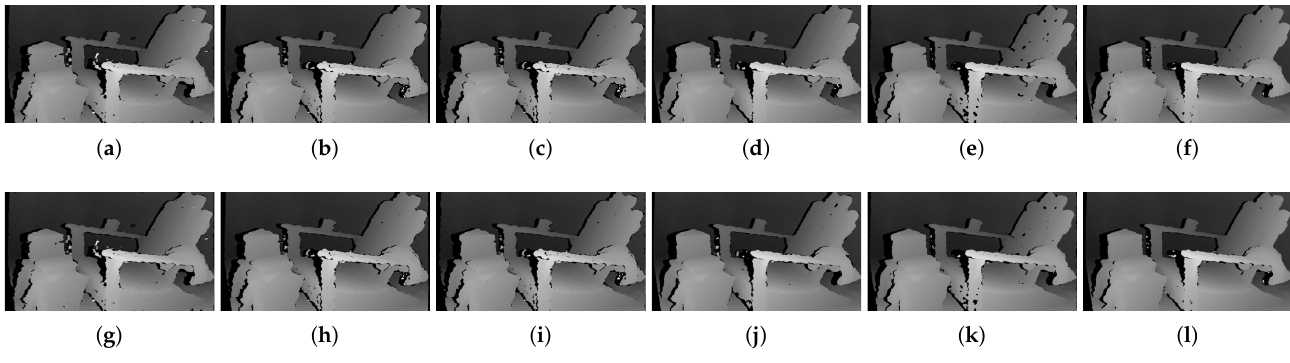
Figure 24. Estimated disparity images of the combinations of cost and image filter using the window- based stereo method, according to low and high gain parameters. The images in the top row show disparities at the low gain parameter, and the images in the bottom row show those at the high gain parameter, respectively. ( a ) Window, SAD. ( b ) Window, Mean/SAD. ( c ) Window, LoG/SAD. ( d ) Win- dow, BilSub/SAD. ( e ) Window, Rank/SAD. ( f ) Window, Census. ( g ) Window, SAD. ( h ) Window, Mean/SAD. ( i ) Window, LoG/SAD. ( j ) Window, BilSub/SAD. ( k ) Window, Rank/SAD. ( l ) Win- dow, Census.